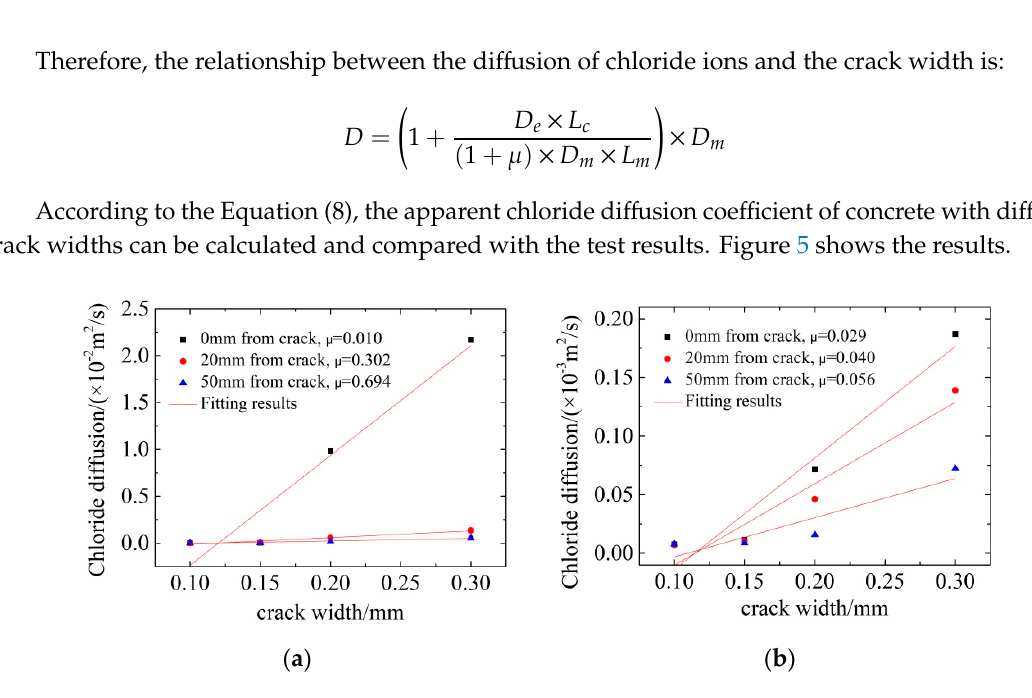
Figure 5. Relationship between diffusion coefficients and distance from crack. ( a ) Concrete with LC; ( b ) Concrete with CR.